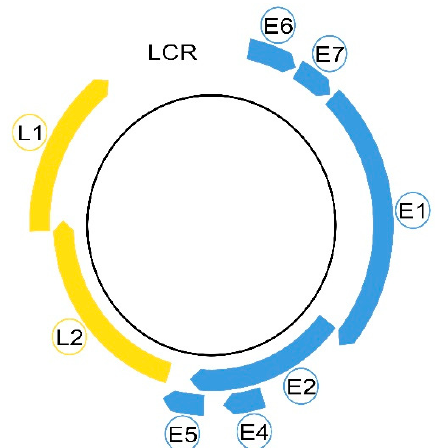
Figure 1. Schematic illustration of a high-risk HPV morphology. The six early genes (E1, E2, E4, E5, E6 and E7) are depicted in blue and the late L1 and L2 in yellow. The free space between L1 and E6 represents the long control region (LCR).